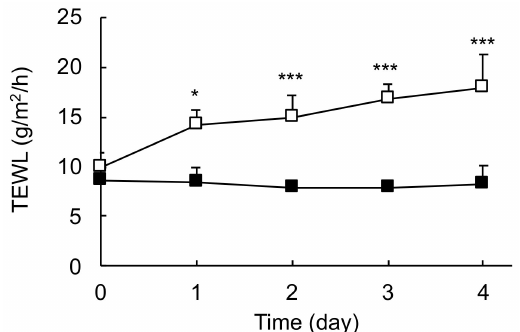
Figure 6. Change in TEWL after the application of MEL-B liposomes and SDS solution. Symbols: closed square, 1% MEL-B liposomes; open square, 1% SDS solution. Values are presented as the mean ± S.D. of three experiments. * p < 0.05, *** p < 0.001 using a Student’s